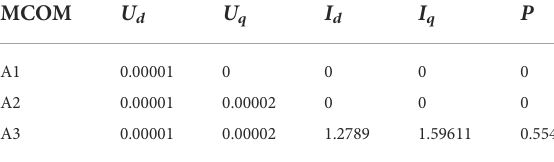
TABLE 2 System component participation coef fi cients.